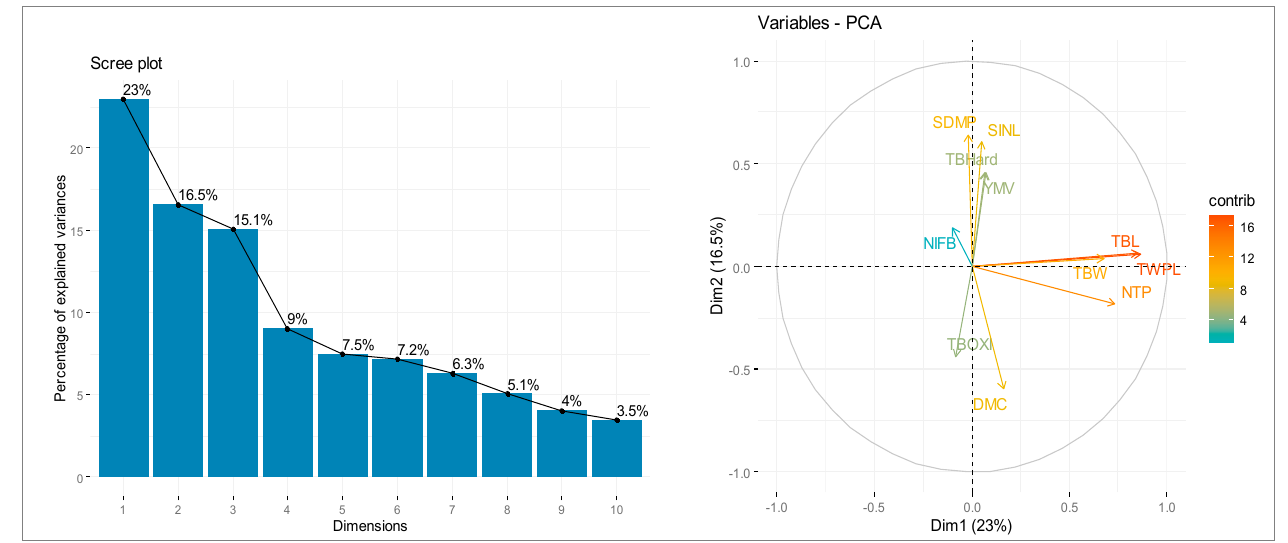
number of tuber per plant ( p <0.01), tuber length ( p < 0.001), and the number of internodes